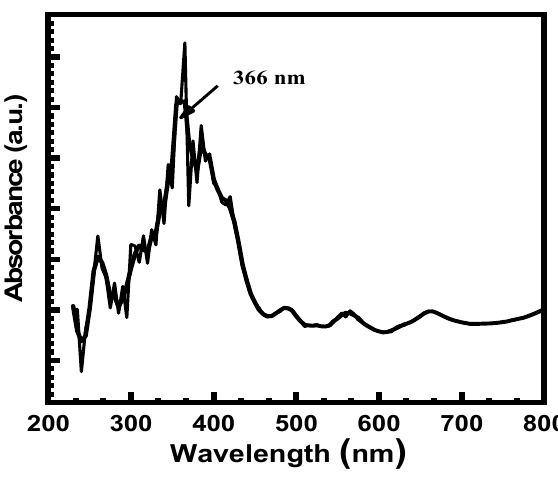
Figure 2. UV-Vis spectra of IONPs.